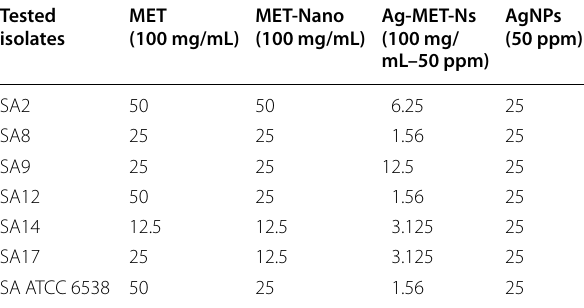
Table 2 MIC values of the tested agents against S.